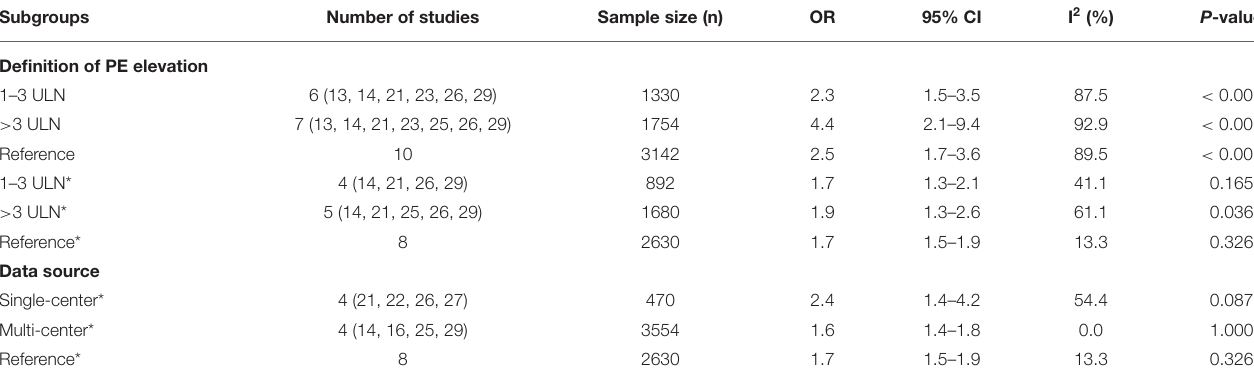
TABLE 2 | Subgroup analysis on the association between of pancreatic enzymes elevation and mortality in COVID-19 patients. Subgroups Number of studies Sample size (n) OR